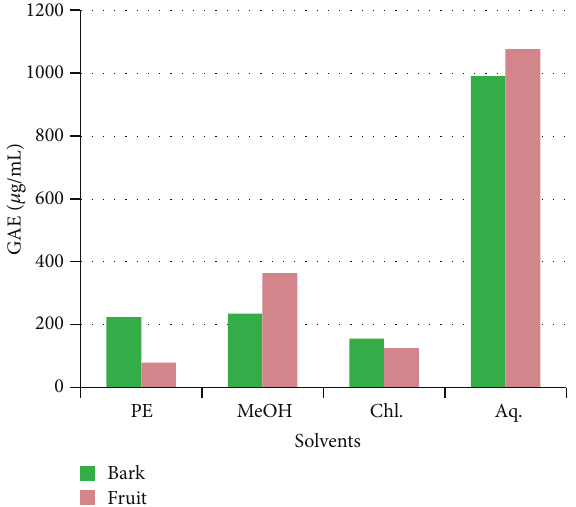
Figure 15: Total phenolic contents (TPC) of different parts of C. ambrosioides